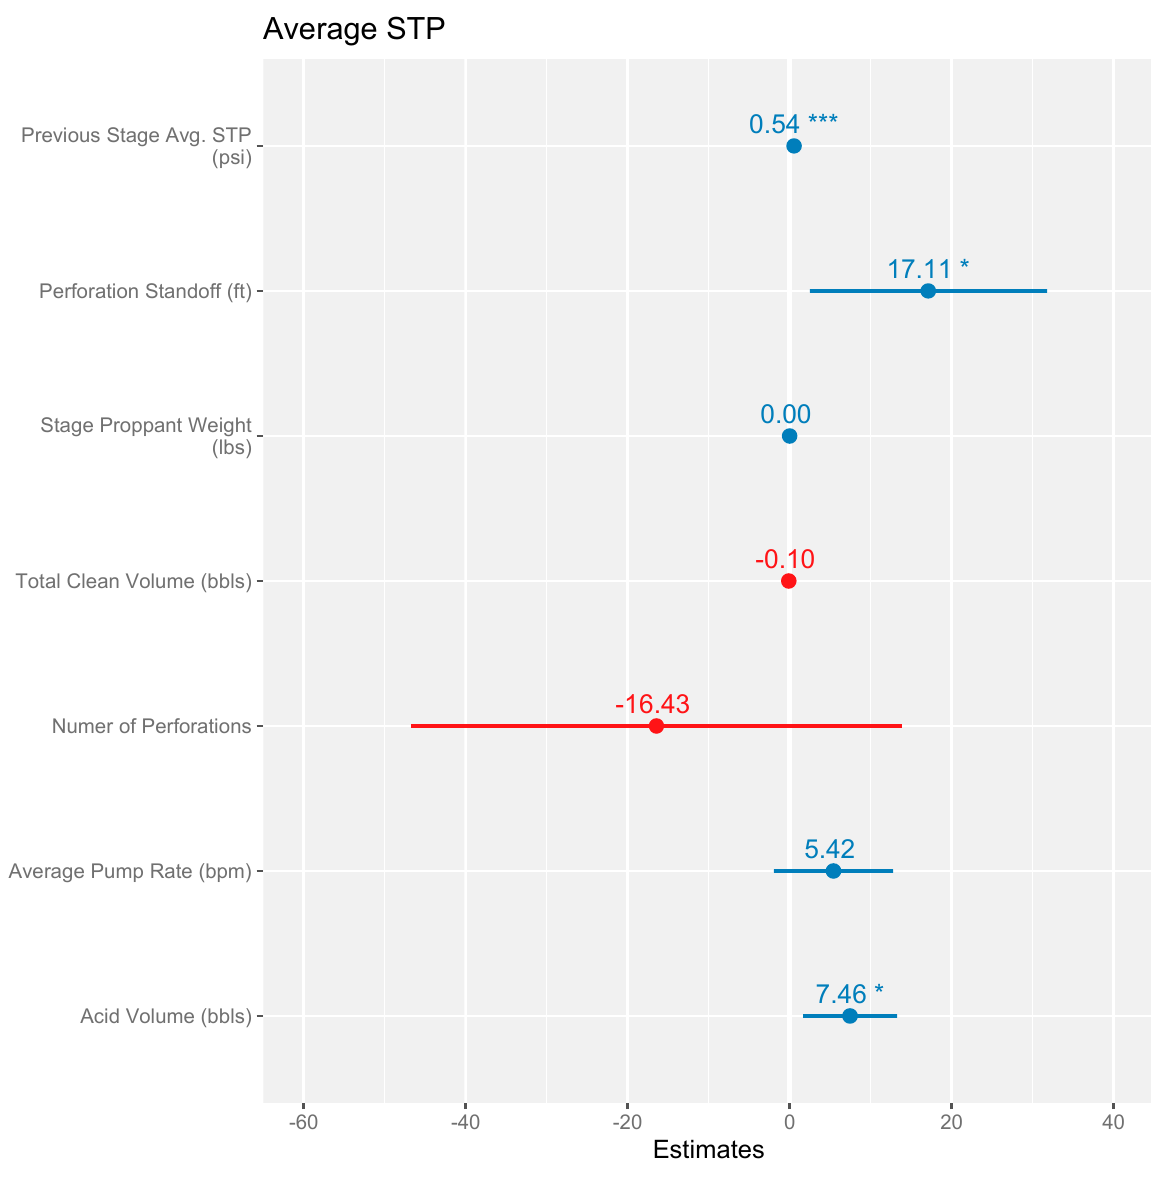
Figure 9. Regression results showing the expected marginal effect of independent variables with associated statistical significance. Note: * p < 0.1; *** p < 0.01.